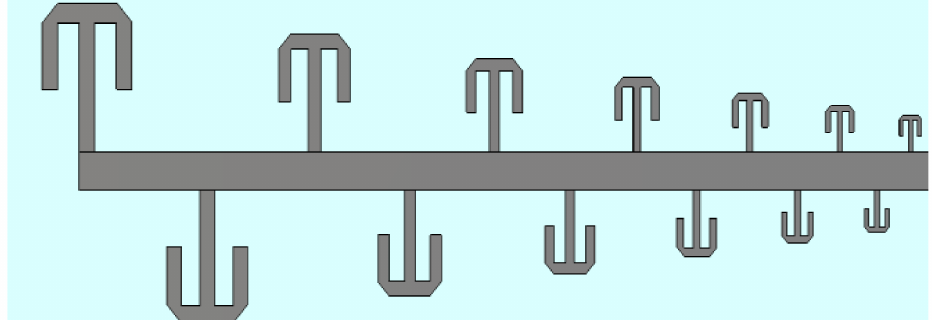
Figure 2. PLPDA design with implemented C-shaped top-loading technique in [26].